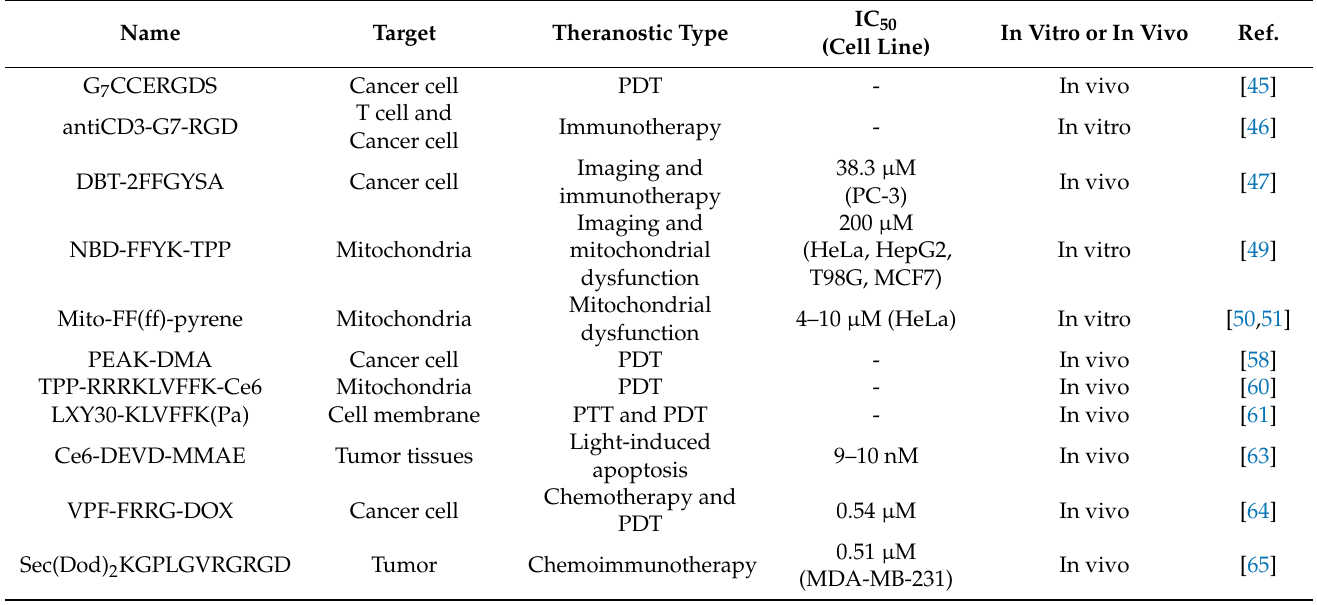
Figure 3. Schematic diagram of transformable peptide nanomaterials with enhanced photother- apeutic effects against cancer. Adapted with permission from [61]. Copyright 2021 American Chemical Society. Table 1. Peptide-based assembly for theranostic